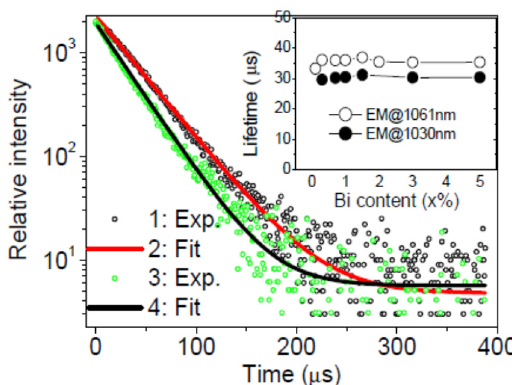
Figure 20. Decay and fit (with simple exponential decay equation) curves of Ba 2(1-x) B 5 O 9 Cl: 2x%Bi (x = 0.7): (1) and (2) for the case of the emission at 1061 nm upon 478 nm excitation, and (3) and (4) for the emission at 1030 nm upon the excitation of 298 nm. Inset shows the dependence of lifetime on the bismuth content x%. Reprinted from [107] with permission.